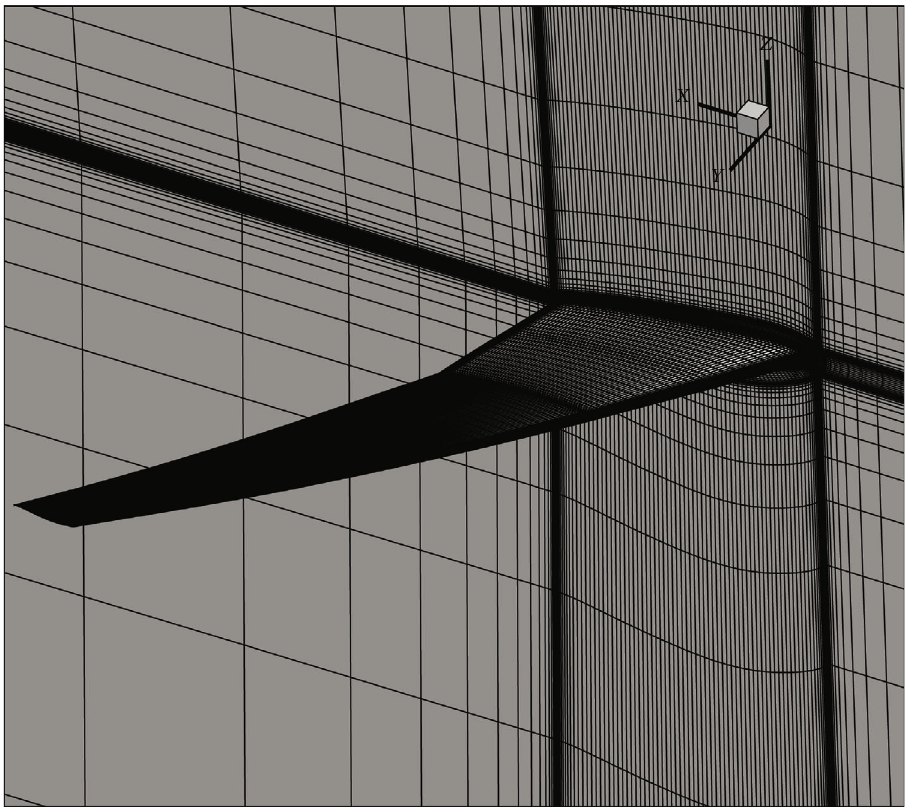
Figure 21: The computational grid of the CRM wing.